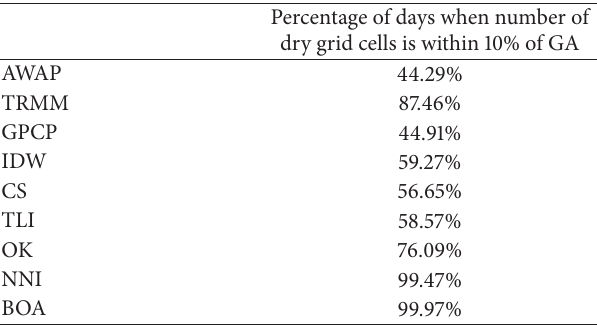
Table1:Percentageofdayswhenthetotalnumberofdrygridcellsis within10%ofthatfromGA.Amaskcorrespondingtothenonempty cells of GA was applied before these